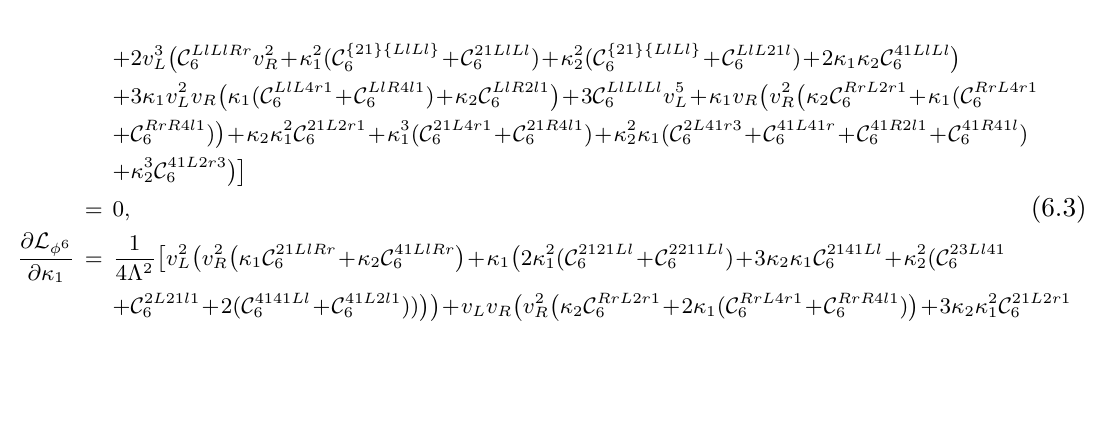
Table 15. MLRSM: (cid:30) 6 [42 2 = 84] class of operators. Each of these operators also has a distinct (cid:2) Hermitian